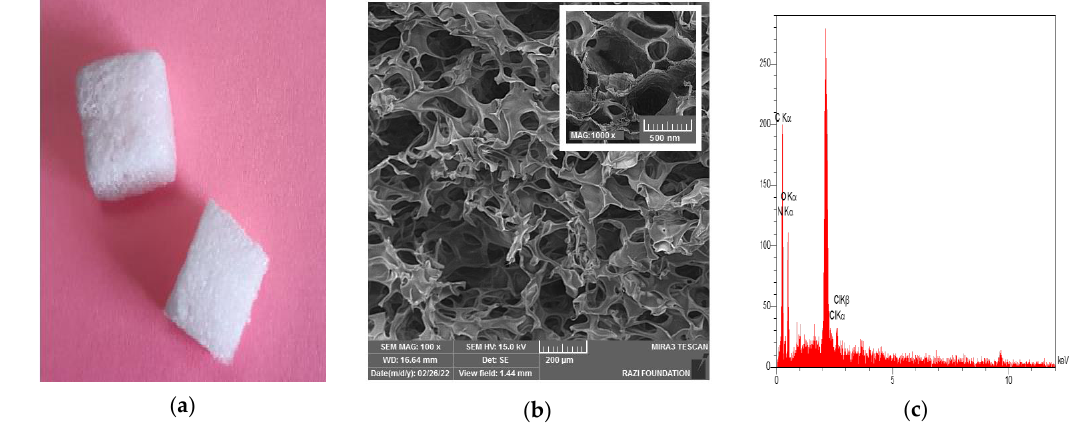
Figure 3. The produced sponge with the dimension of 10 × 10 × 10 mm ( a ). The SEM image of the sponge ( b ) and the EDX analysis ( c ).